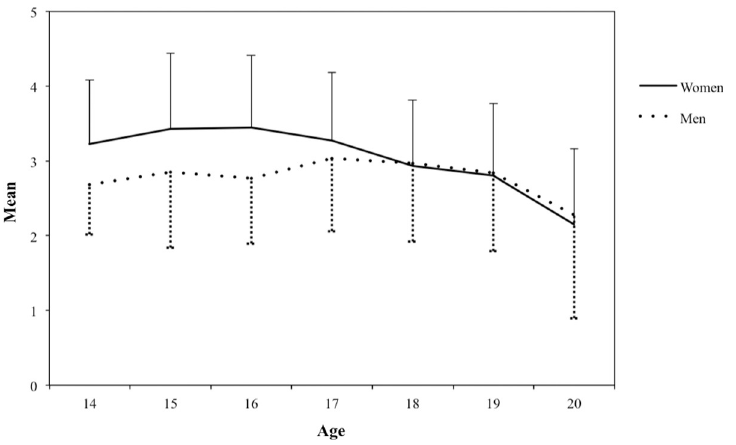
Fig 5. Interaction between gender and age variables for Mellow styles.